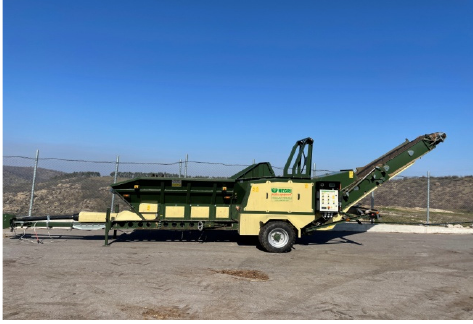
Figure 3. Mobile shredder, R 640TN, NRGRI.